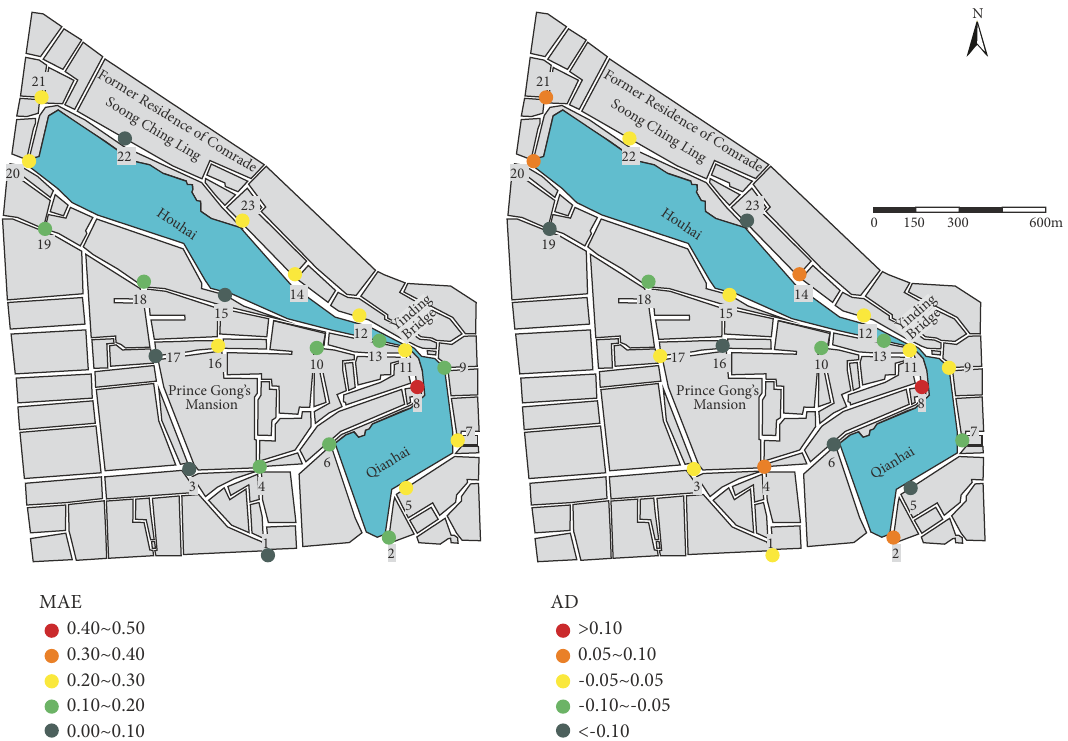
00.10.20.30.40.50.6 E A M